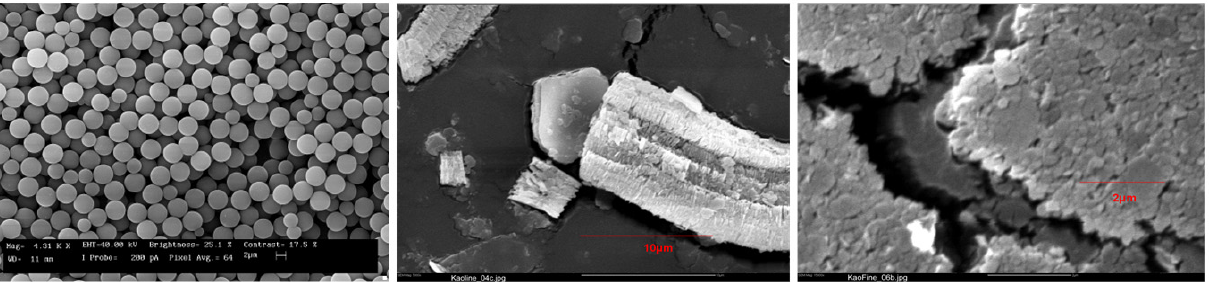
Figure 1. SEM image of a silica (left), kaolinite (center) and Kaofine (right).